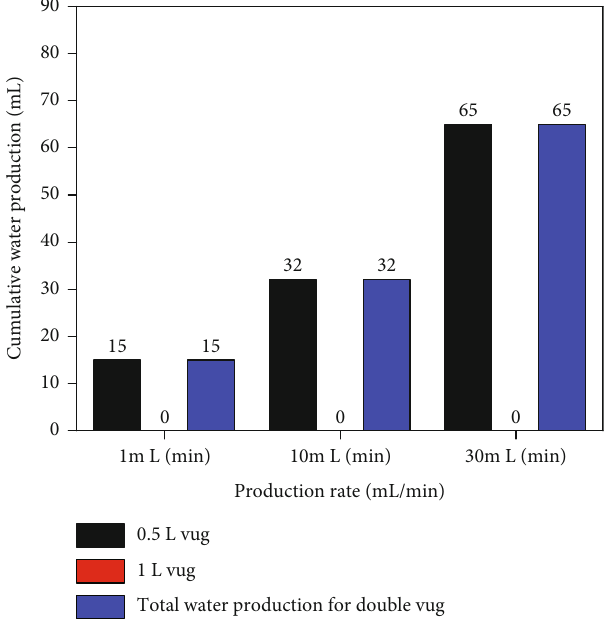
Figure 10: Column chart of cumulative water production in high- pressure physical property experiments under connection type II (di ff erent production rates).